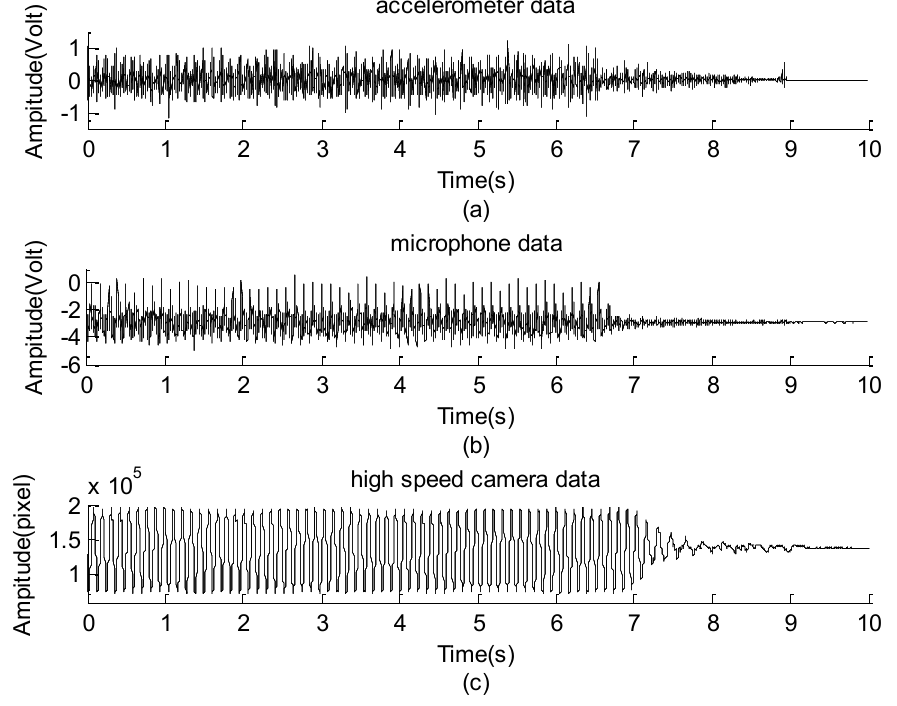
Figure 14. The raw data of the small helicopter in operation captured by: ( a ) accelerometer. ( b ) microphone. ( c ) high speed camera. accelerometer data